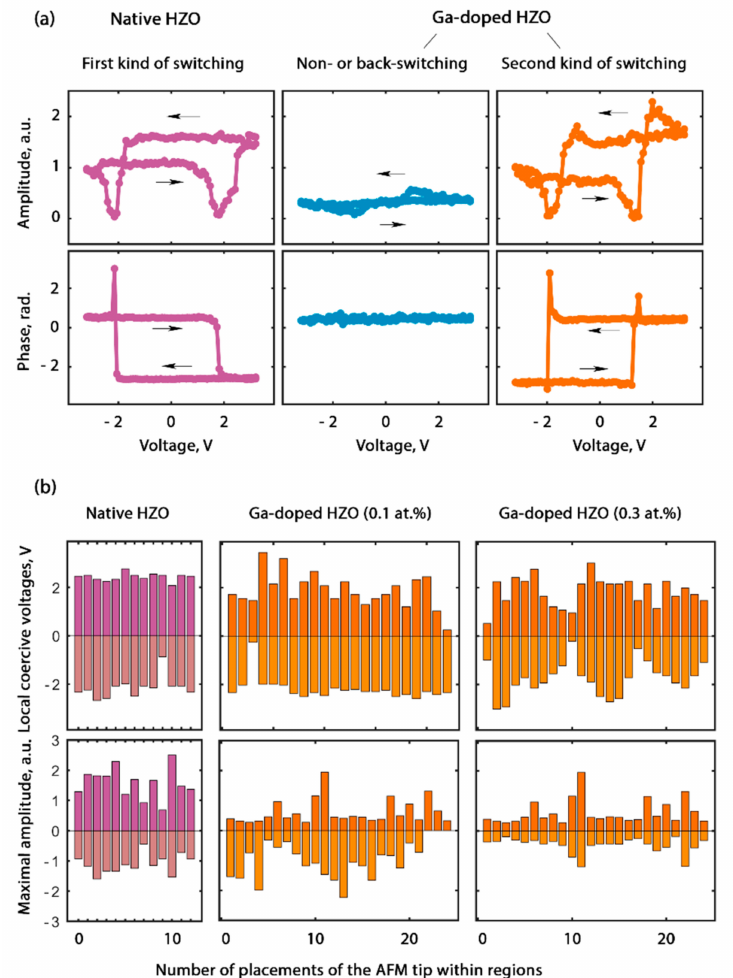
Figure 5. Local SS–PFM loops measured within the native and doped HZO regions: ( a ) three types of loop (the left curves are typical for native HZO, while the middle and right curves are both typical for HZO doped with 0.1 at.%). ( b ) Local coercive voltages and maximal amplitude during the local switching in a number of AFM tip locations within different HZO